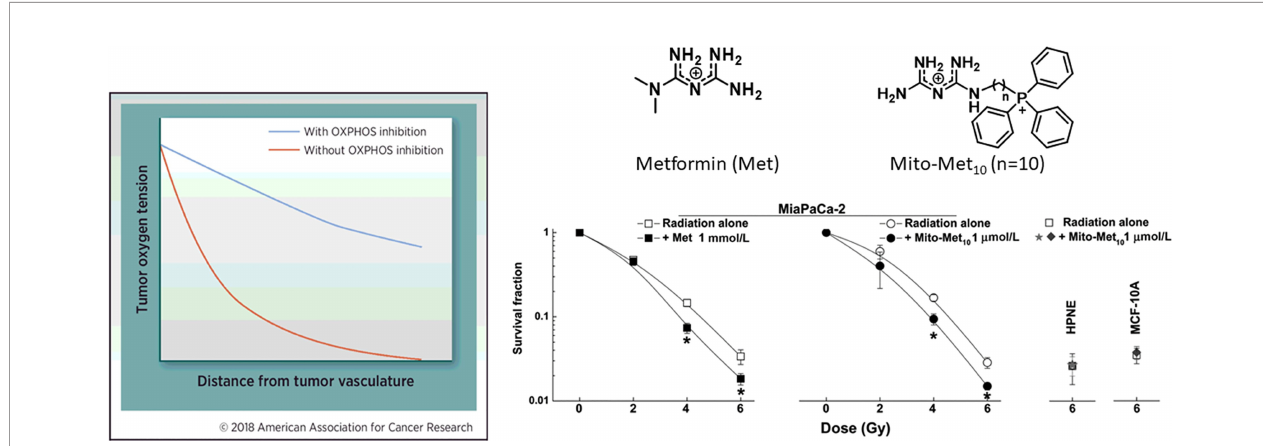
FIGURE 5 | Mitochondria-targeted metformin enhances oxygen concentration in pancreatic cancer cells by inhibiting mitochondrial respiration and makes these cells more vulnerable to radiation. *, P < 0.05 compared with radiation alone. The left portion of the fi gure is reprinted from Clinical Cancer Research, 2018,